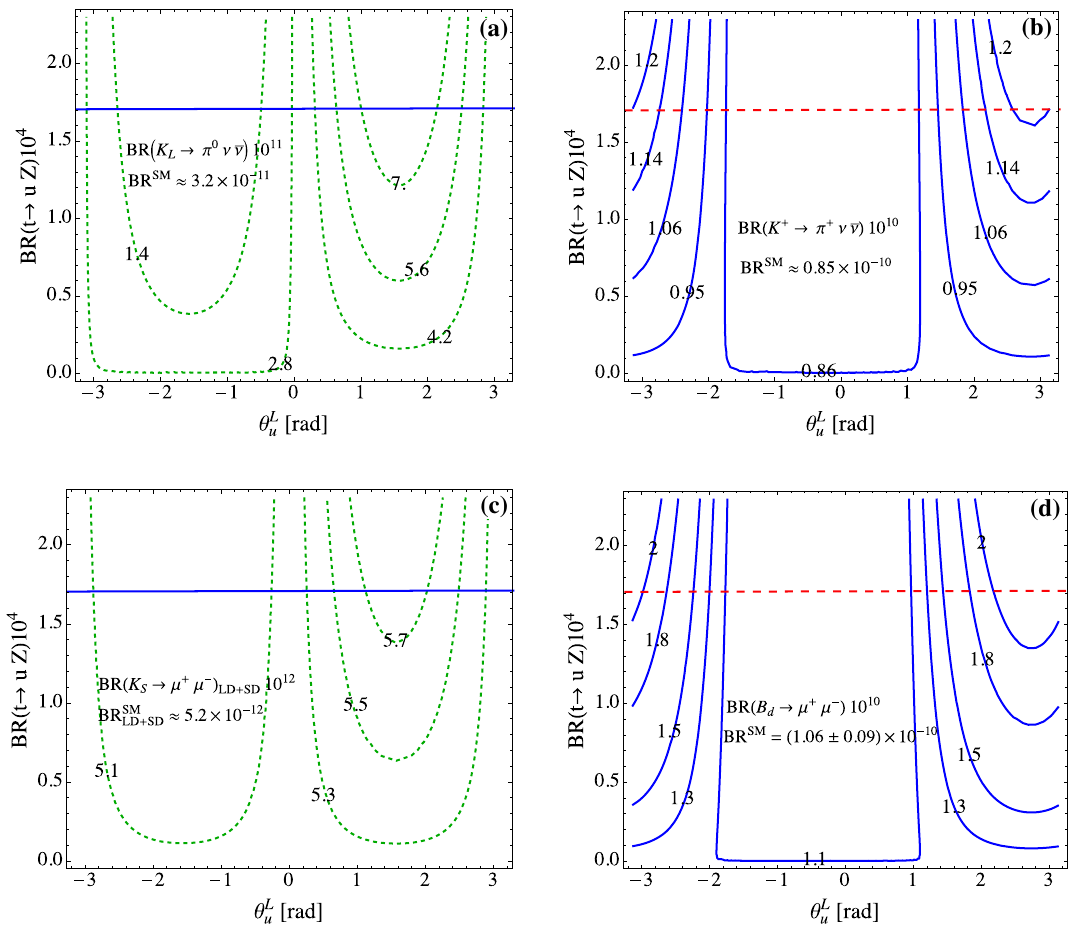
Fig. 3 Contours of the branching ratio as a function of BR ( t → uZ ) and θ L u for a K L → π 0 ν ¯ ν , b K + → π + ν ¯ ν , c K S → μ + μ − , and d B d → μ + μ − , where the corresponding SM result is also shown in each plot. The long-distance effect has been included in the K S → μ + μ −